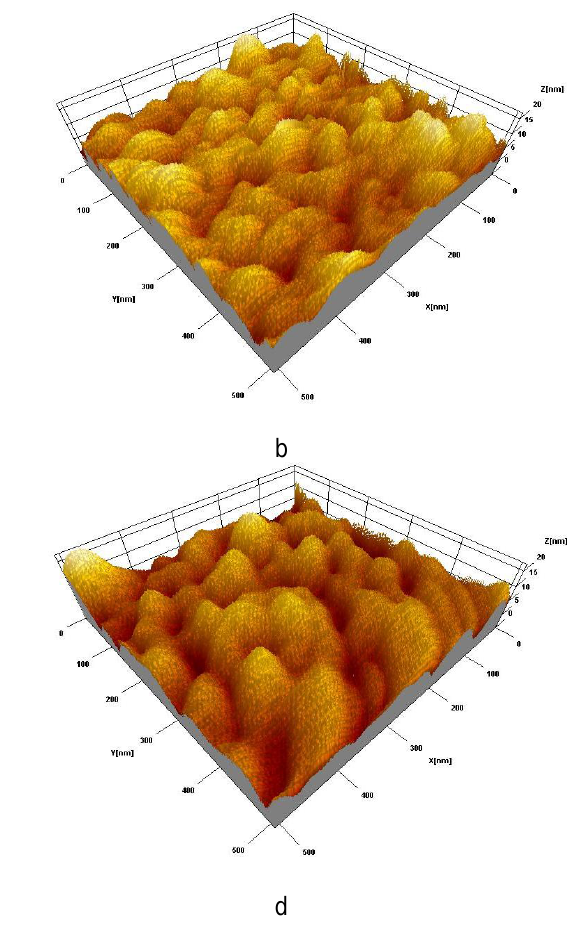
Figure 1. SPM images of a nano-porous aluminum surface: silanized with APTES (a); with anti-SEB immobilized (b); empty sites blocked with ethanolamine (c); morphology changes due to immunoreaction